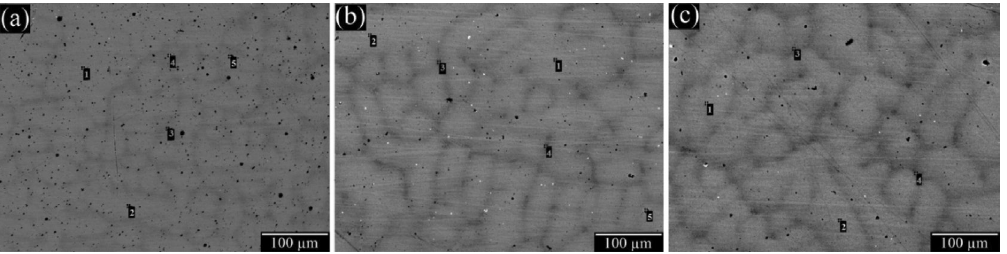
Fig. 9: Back scattered electron images of SHS alloys with 5Al-20Co-75Ni estimated composition under a) 1 g-force, b) 110 g-force, c) 1000 g-force of artificial gravity conditions